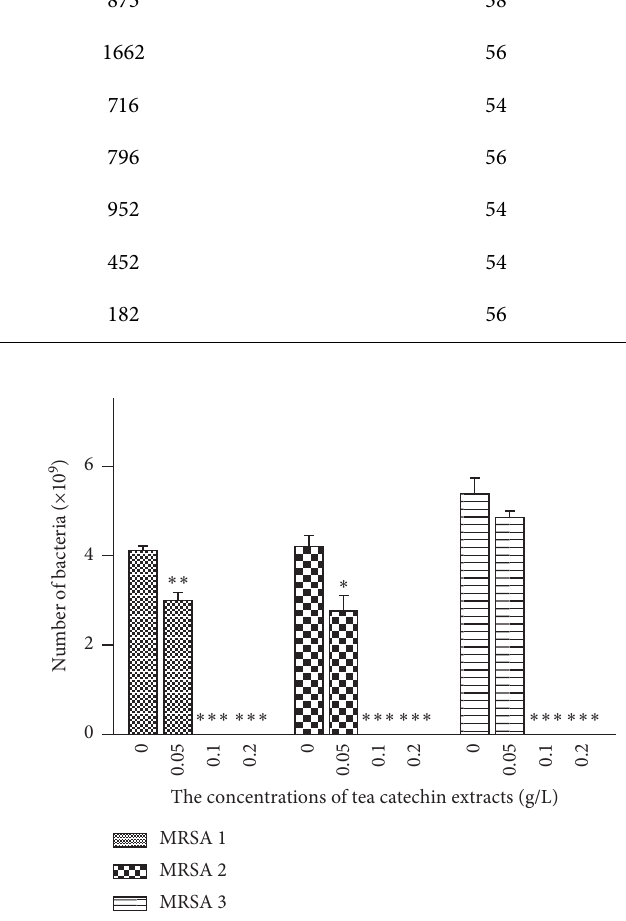
Figure 1: The effect of tea catechin extracts on the growth of methicillin-resistant S. aureus (MRSA) strains. 2 × 10 5 cfu MRSA isolates were inoculated in 250mL tryptone soya broth (TSB) supplemented with 0.8 g/L, 0.4g/L, 0.2 g/L 0.1 g/L, and 0.05g/L tea catechin extracts and incubated at 37 ° C for 24hours.